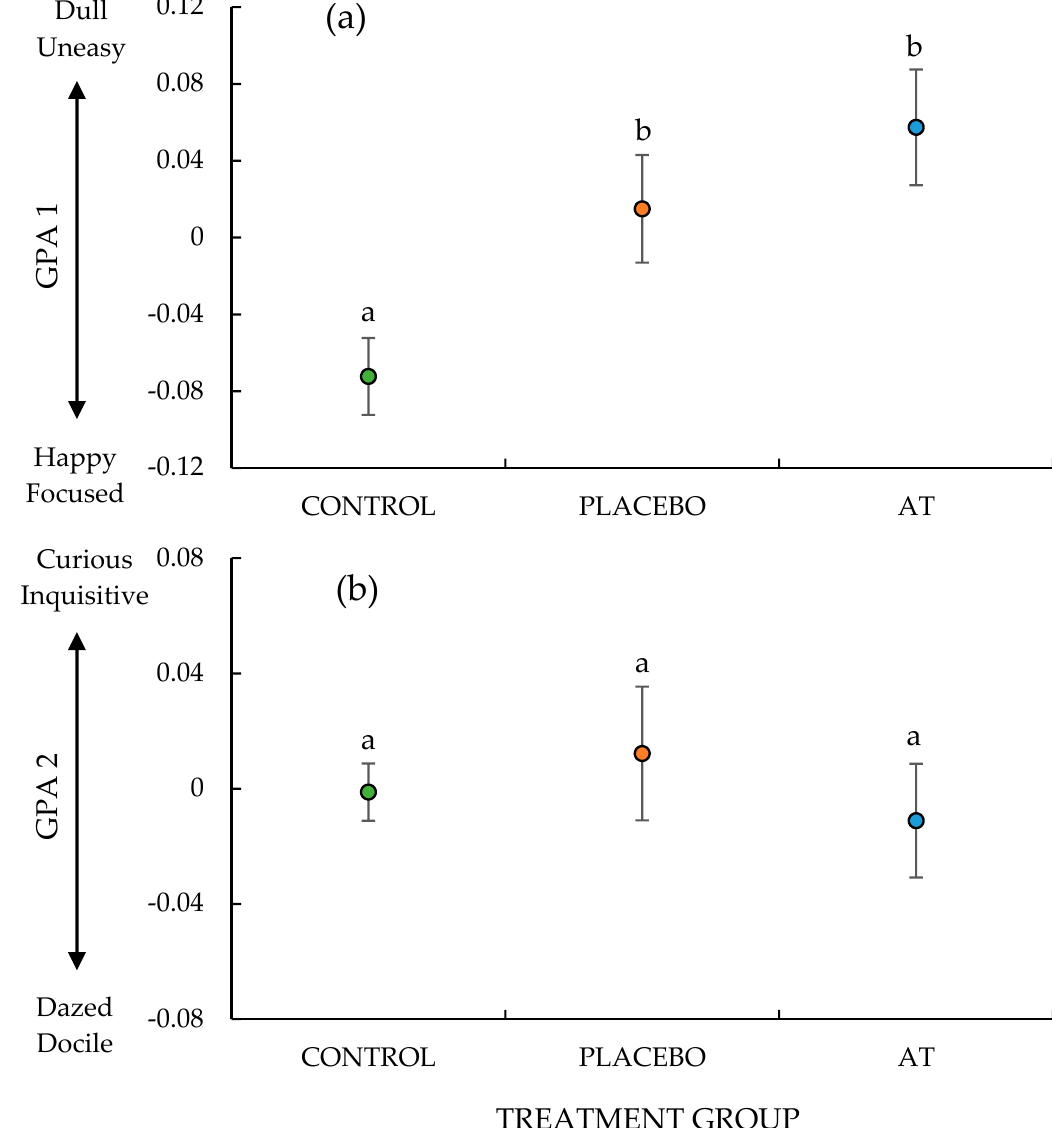
Figure 1. Effects of the treatment groups: CONTROL (green marker; n = 10), PLACEBO (orange marker; n = 10) and ANALGESIC TREATMENT (AT) (blue marker; n = 10) on General Procrustes Analysis (GPA) scores on dimension ( a ) 1 and ( b ) 2, assessed from video footage taken of lambs in the paddock approximately 1.5 h post-procedure. a and b indicate significant differences between treatment groups.